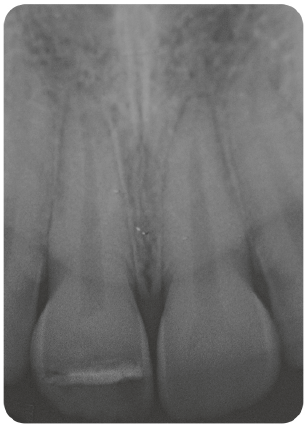
Figure 6: Radiograph showing periapical